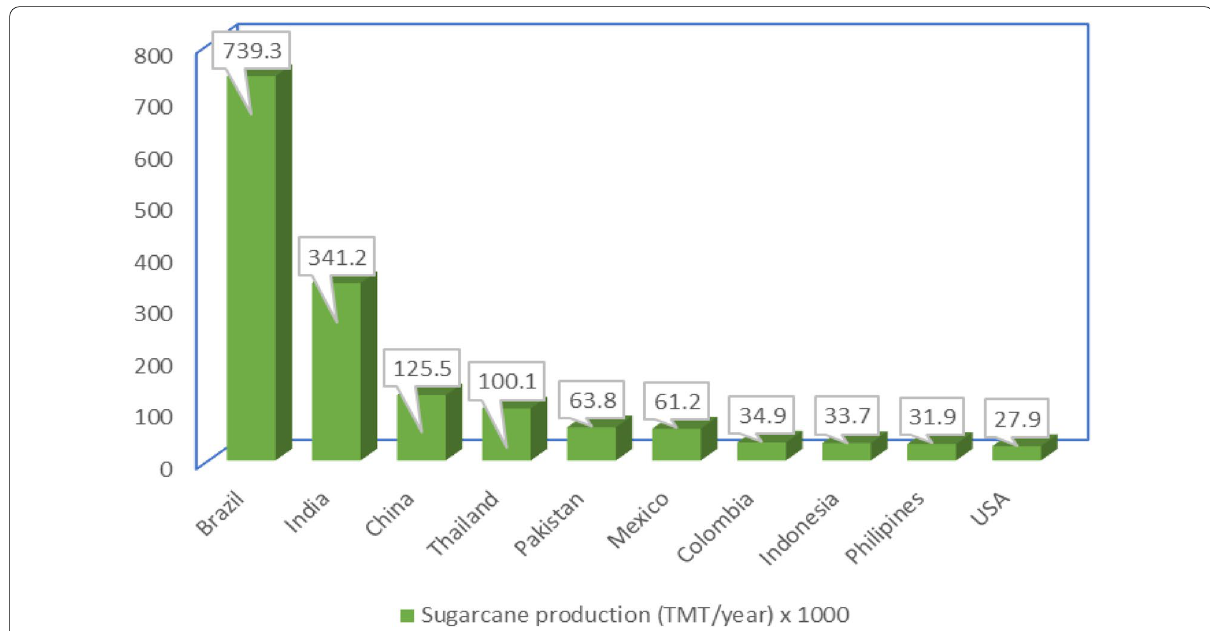
Fig. 1 Top 10 producers of sugarcane globally (Khoo et al. 2018)